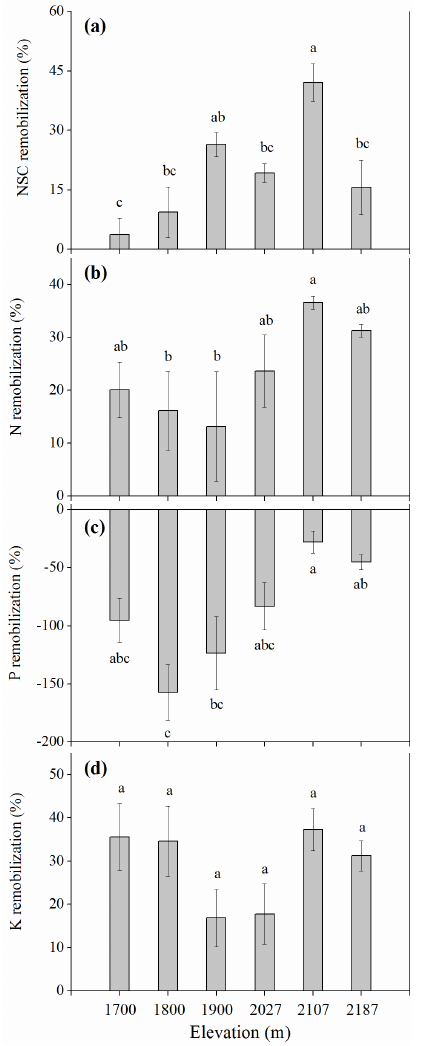
Figure 6. Carbohydrates, N, P and K remobilization efficiency (Mean ± 1SE) (R%) in Betula ermanii trees along the altitudinal gradients in Changbai Mountain ( n = 5 for each elevational site). R% was calculated using R % = (( C l − C s ) / C l ) × 100% = ( 1 − C s / C l ) × 100%, where C l and C s represent concentrations in leaves and shoots at the end of growing season, respectively. Different letters display significant differences at the 0.05 level among elevations as determined by Tukey’s HSD test (The larger the R -value, the lower the remobilization efficiency